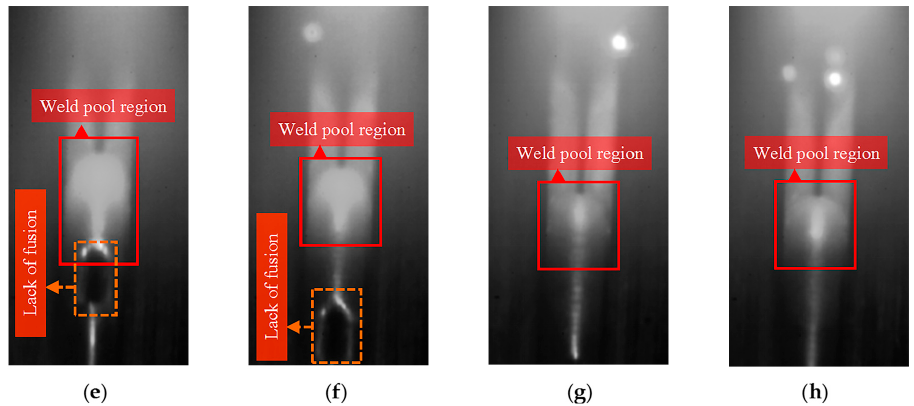
Figure 11. A typical weld pool behavior during the formation of lack of fusion in MPAW of edge weld. ( a ) t 0 ; ( b ) t 0 + 80 ms; ( c ) t 0 + 160 ms; ( d ) t 0 + 240 ms; ( e ) t 0 + 320 ms; ( f ) t 0 + 400 ms; ( g ) t 0 + 480 ms; and, ( h ) t 0 + 560 ms.